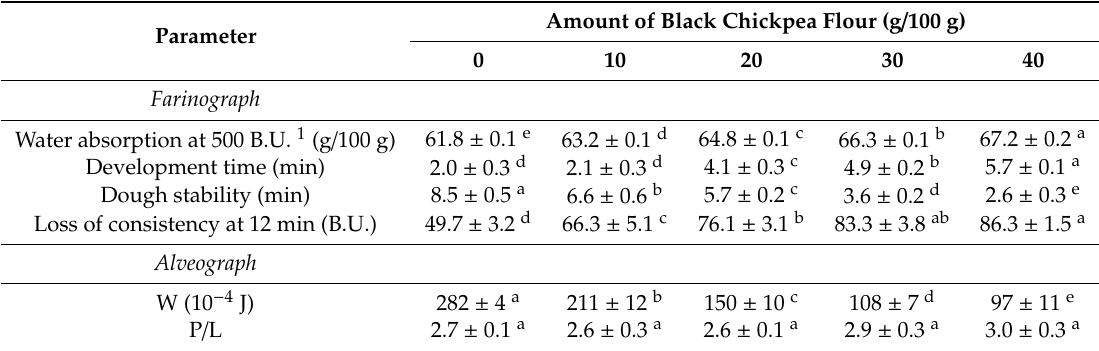
Table 3. Farinograph and alveograph data of pure durum wheat re-milled semolina and of blends with increasing amounts of Apulian black chickpea wholemeal flour.